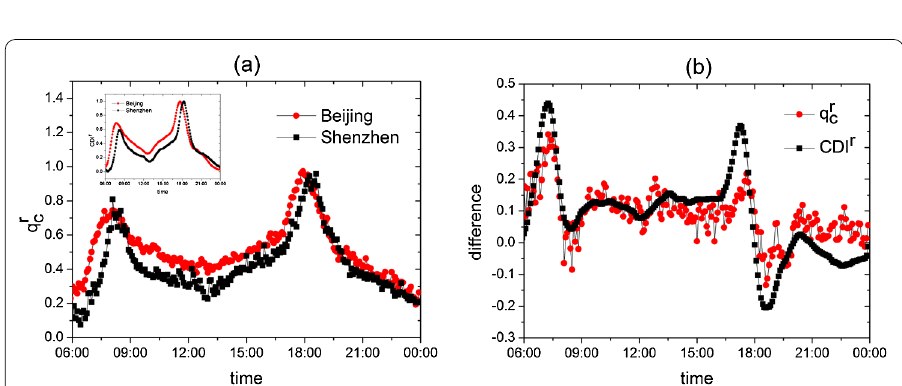
Figure 10 Traffic reliability indices in different cities. (a) q r c as the function of time in Beijing and Shenzhen in workdays. Inset: CDI r as the function of time in Beijing and Shenzhen in workdays. The results are the average of 16 workdays’ results. (b) The difference of index between different cities as the function of time. y -axis is the difference between the average q r c ( CDI r ) values of Beijing and Shenzhen at each instant.